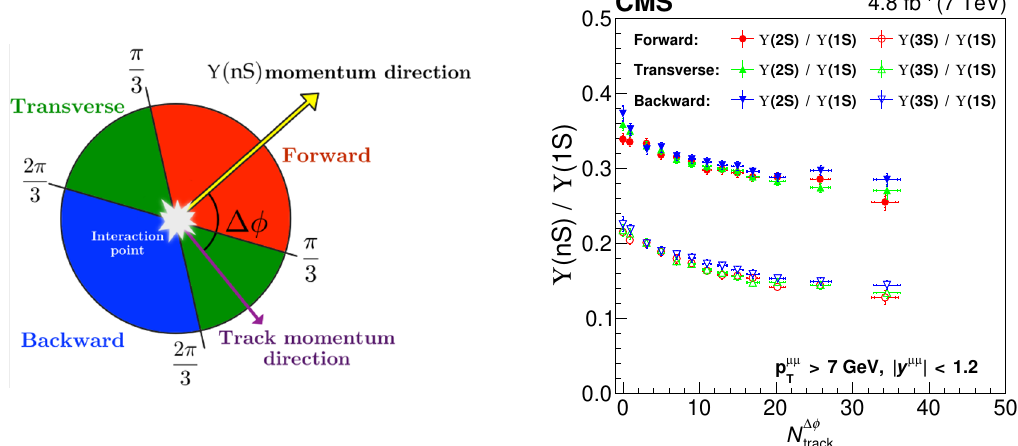
Figure 5 . Left: a schematic view in the azimuthal plane of the three (cid:1) (cid:30) regions with respect to the (cid:7) (nS) momentum direction. Right: the ratios (cid:7) (2S) = (cid:7) (1S) and (cid:7) (3S) = (cid:7) (1S), as a function of N (cid:1) (cid:30) for the three (cid:1) (cid:30) regions shown in the left plot. The outer vertical bars represent the track combined statistical and systematic uncertainties in the ratios, while the horizontal bars give the (cid:10) (cid:11) uncertainty in N (cid:1) (cid:30) for each bin. Inner tick marks show only the statistical uncertainty, both track (cid:10) (cid:11) in the ratio and in N (cid:1) (cid:30) track